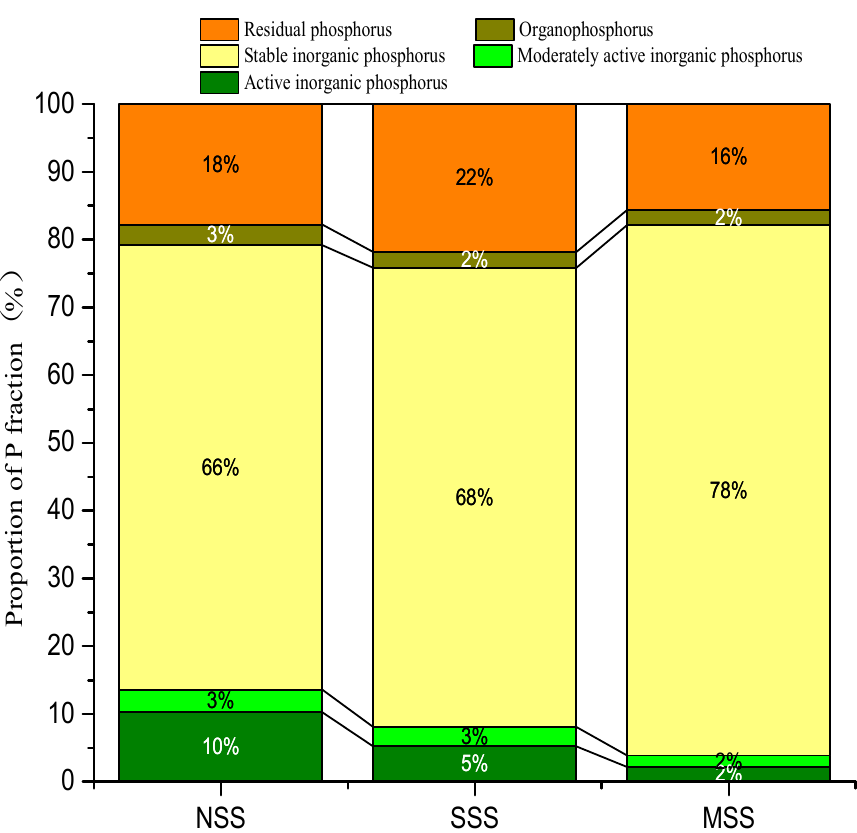
Figure 2. Proportion of various phosphorus forms in Hedley classification.